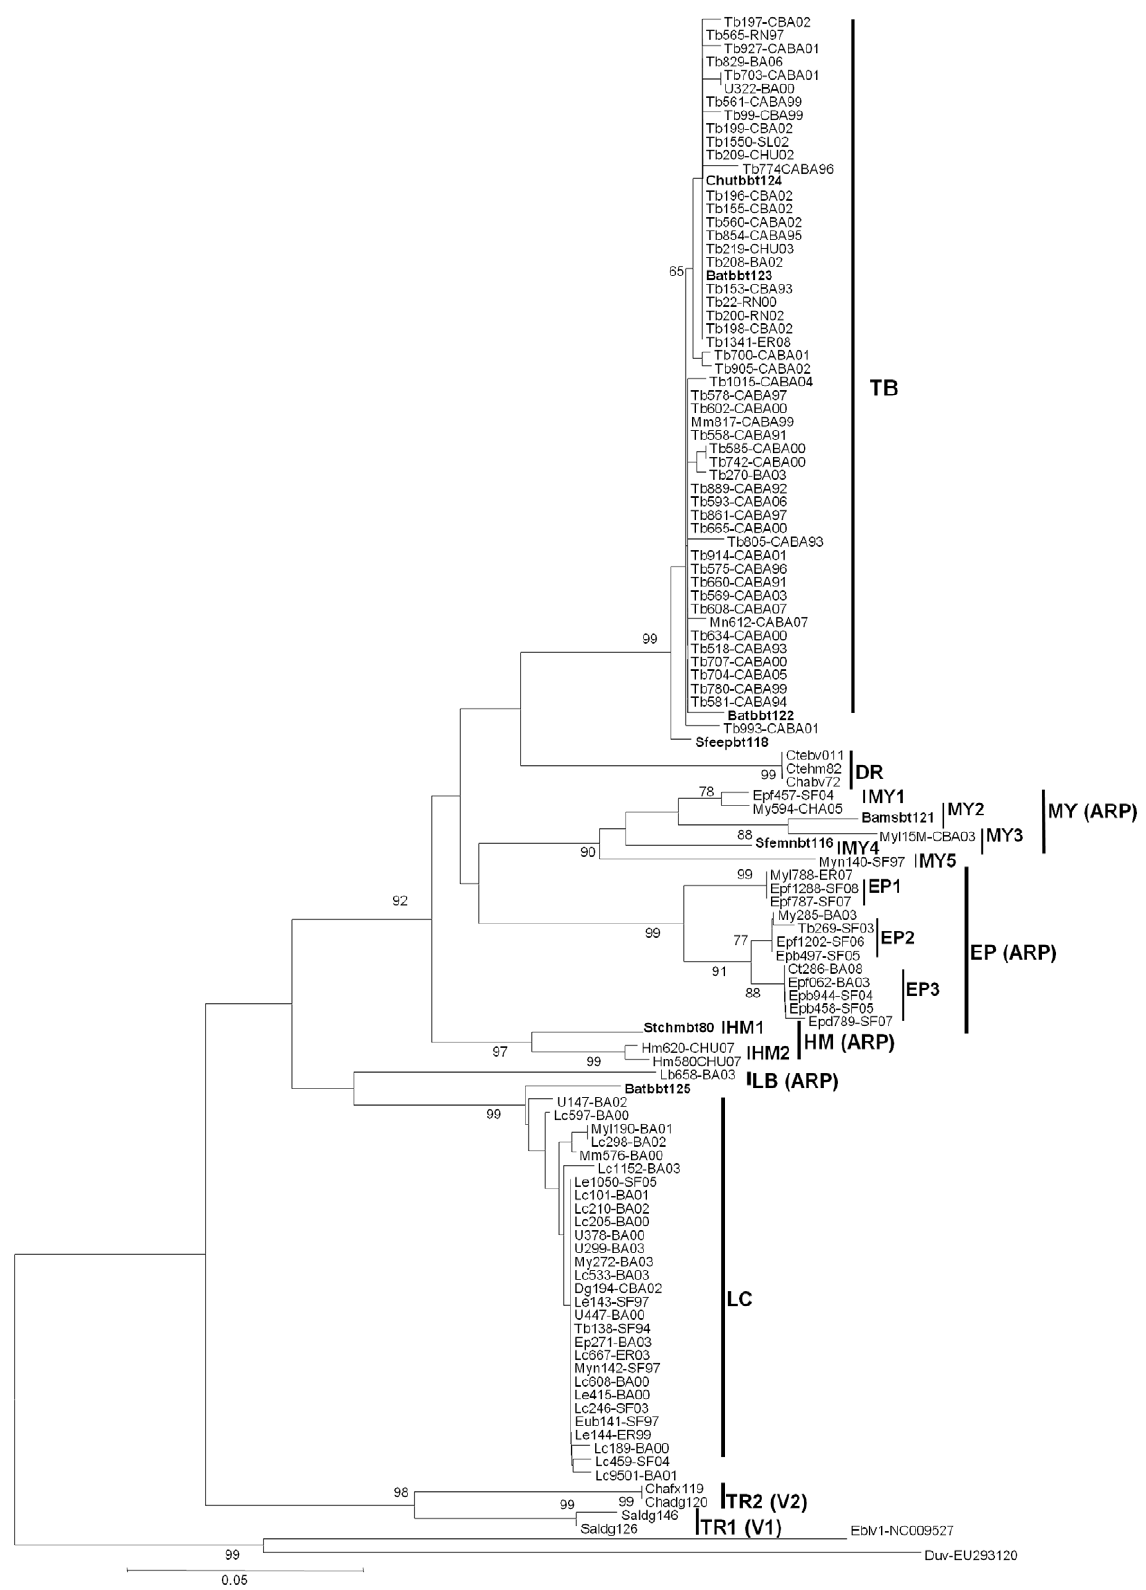
Figure 1. Phylogenetic relationships among Argentinean isolates. Analysis was based on 264 nt of the nucleoprotein gene. A tree was constructed based on Kimura and neighbor joining parameters. TB, Tadarida brasiliensis ; DR, Desmodus rotundus ; MY, Myotis spp. ; HM, Histiotus montanus ; EP, Eptesicus spp ; LB, Lasiurus blosseviilli ; LA, Lasiurus cinereus ; TR, Terrestrial.